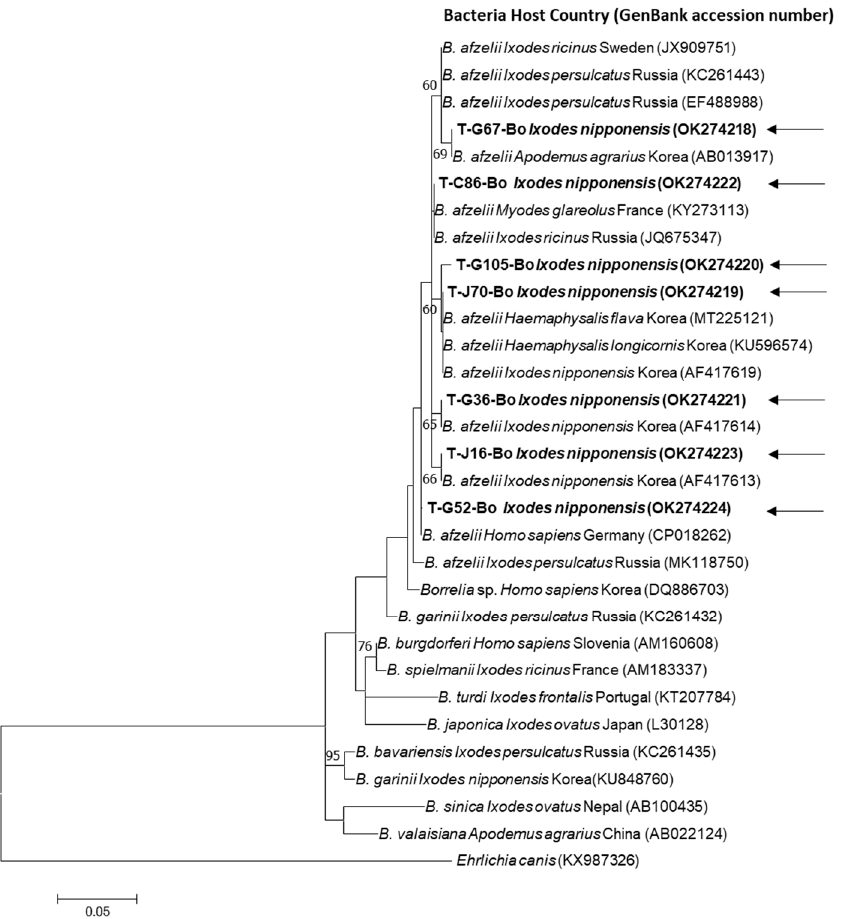
Figure 2. Phylogenetic analysis of Borrelia spp. according to the 5S–23S intergenic spacer region. The tree was constructed using the maximum likelihood method, MEGA 7.0. Sequences identified in this study are indicated by bold and black arrows.